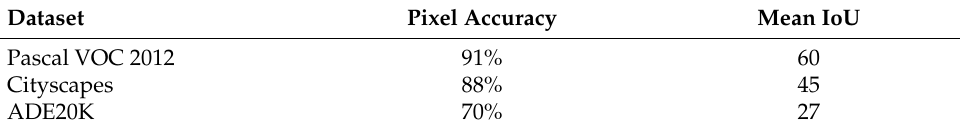
Table 9. Results on the datasets when using data augmentations.